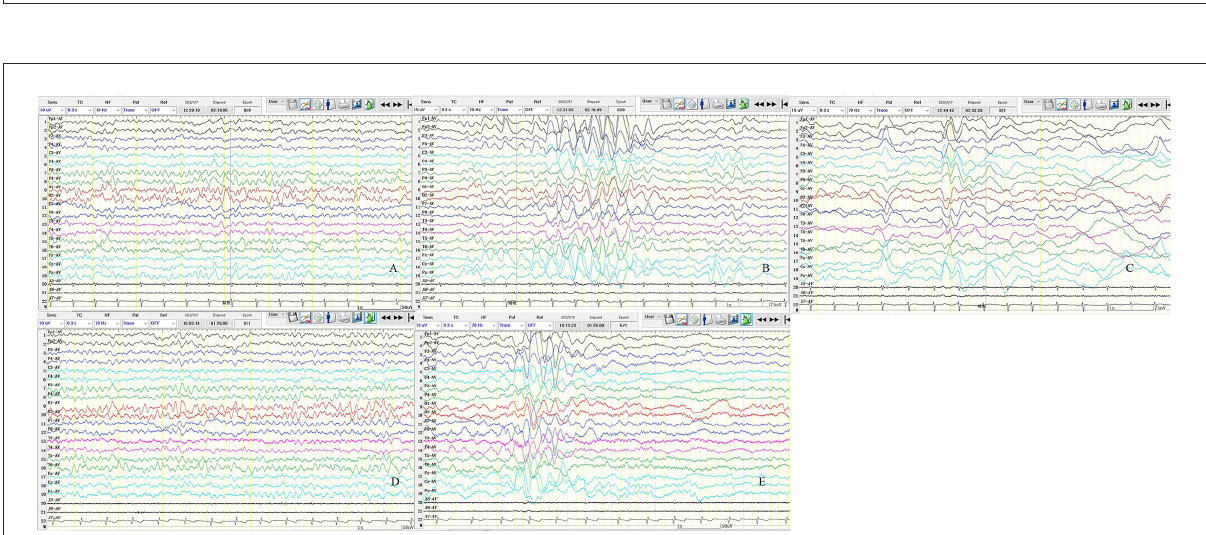
FIGURE4 Results of two video-encephalographies (VEEGs) performed 35 days after discharge (A–C) and 7 months after discharge (D,E) . (A) The 8–9Hz medium amplitude α wave rhythm in the bilateral occipital area. (B) The 3–4Hz slow waves in the bilateral anterior head are asynchronous or rhythmic discharge. (C) Slow wave or sharp slow wave discharged in the bilateral frontal, central, parietal, and midline areas asynchronously. (D) The 6–7Hz medium amplitude θ wave rhythm in the bilateral occipital area. (E) The 3–4Hz slow waves discharge in sleep, and the bilateral anterior head is predominant. X5, Left upper limb; X6, left upper limb; X7, ECG; SEN,10 uV in A, D, E and 15 uV in B, C; HF, 70; TC,